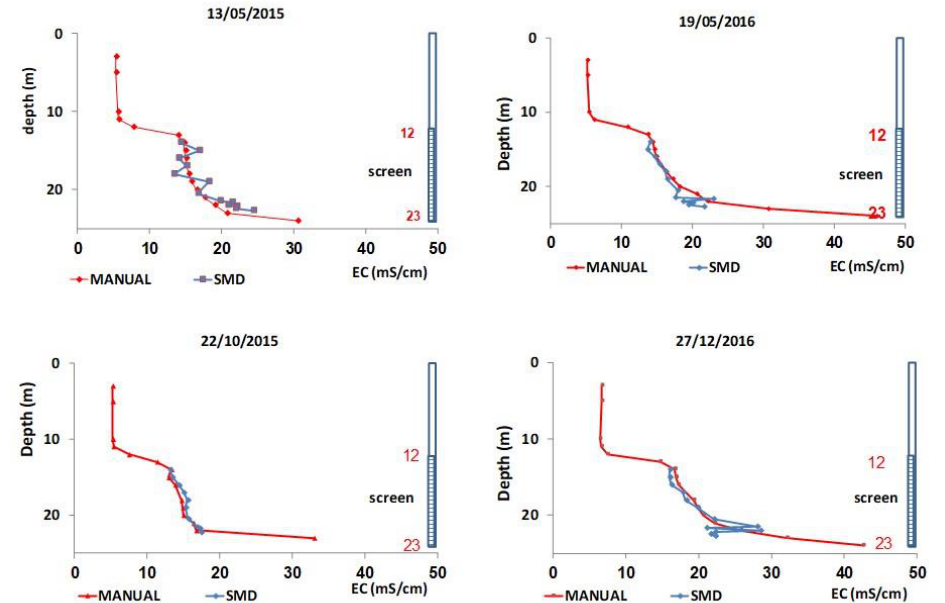
Figure 6. Water electrical conductivity profiles obtained by the SMD method, compared with manual the Robertson Geologging (RG) profiler measurements in well 71-2. Temperature changed between 23.3 °C (12 m depth) to 23.8 °C (23 m depth), exhibiting relatively stable behavior during the year.